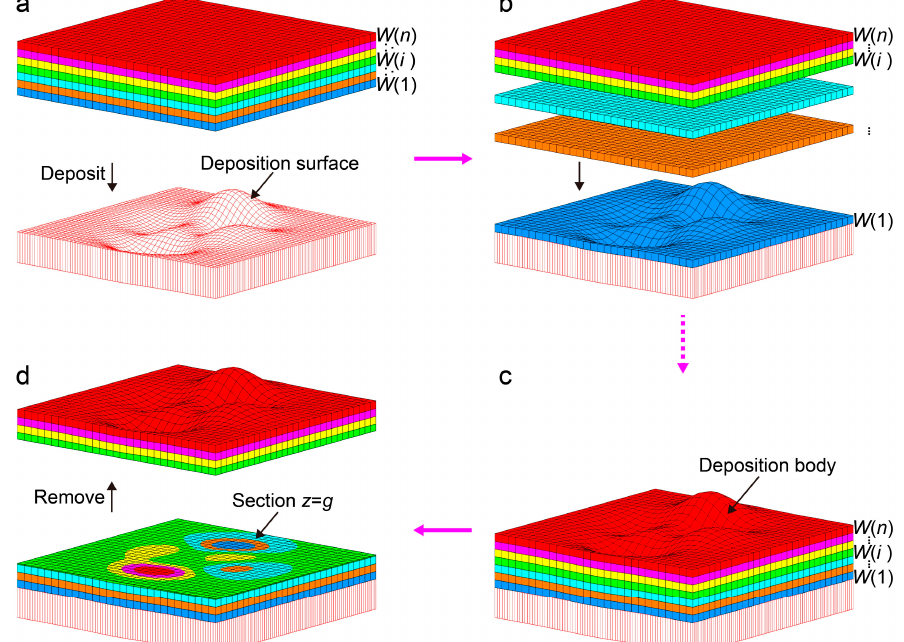
Figure 2. Schematic diagram of LMP-deposition model, LMP-deposition process, and actual distribution. ( a ) Schematic diagram of LMP-deposition model; ( b , c ) Schematic diagram of